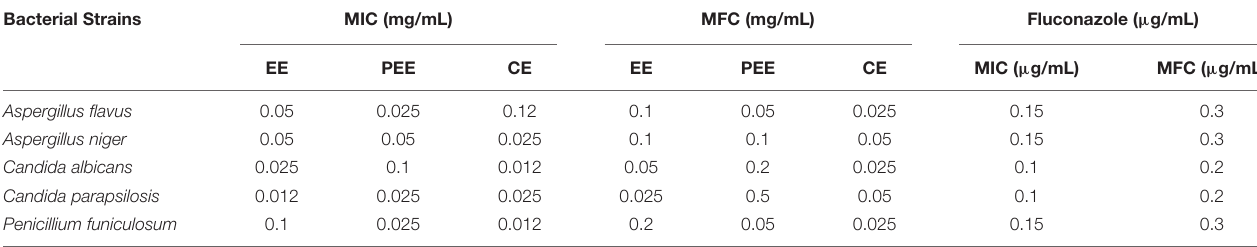
TABLE 8 | Antifungal activity of A. laxmannii extracts (MIC, MFC). Bacterial Strains